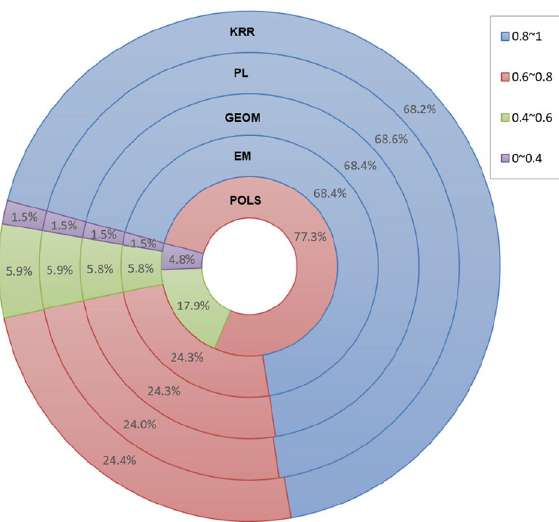
Figure 9. Distribution ratio of cosine